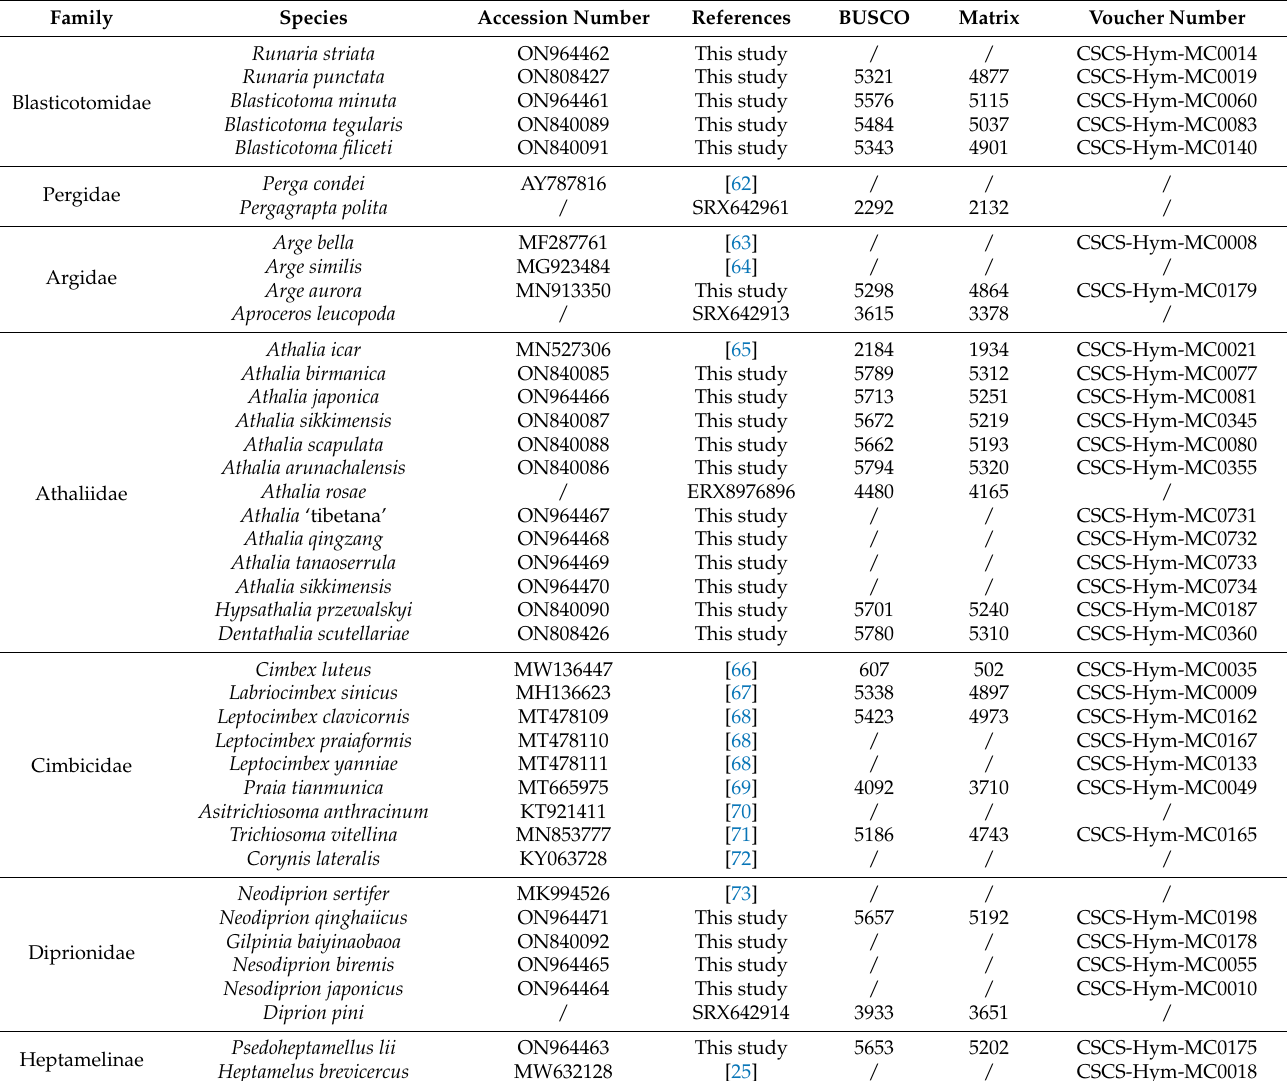
Table 1. Summary information of mitogenomes and the Single-copy Orthologs (SCOs) used in phylogenetic